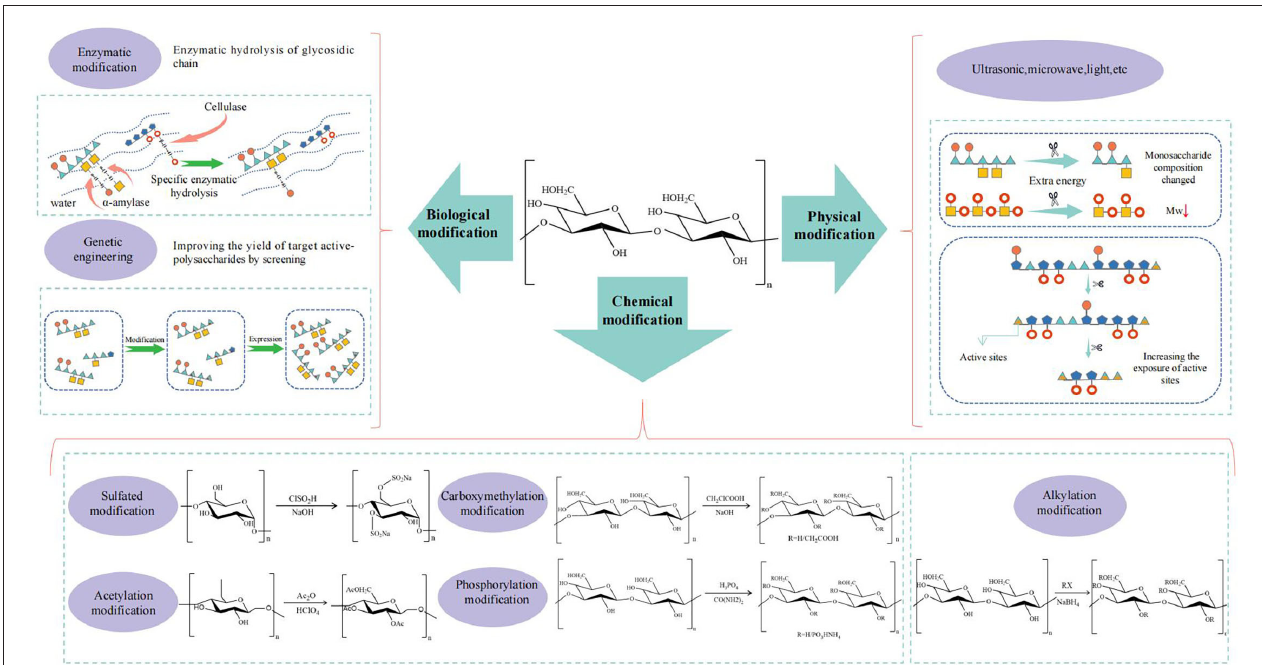
FIGURE 5 | The schematic diagram of relationship between structural modification and biological activity of